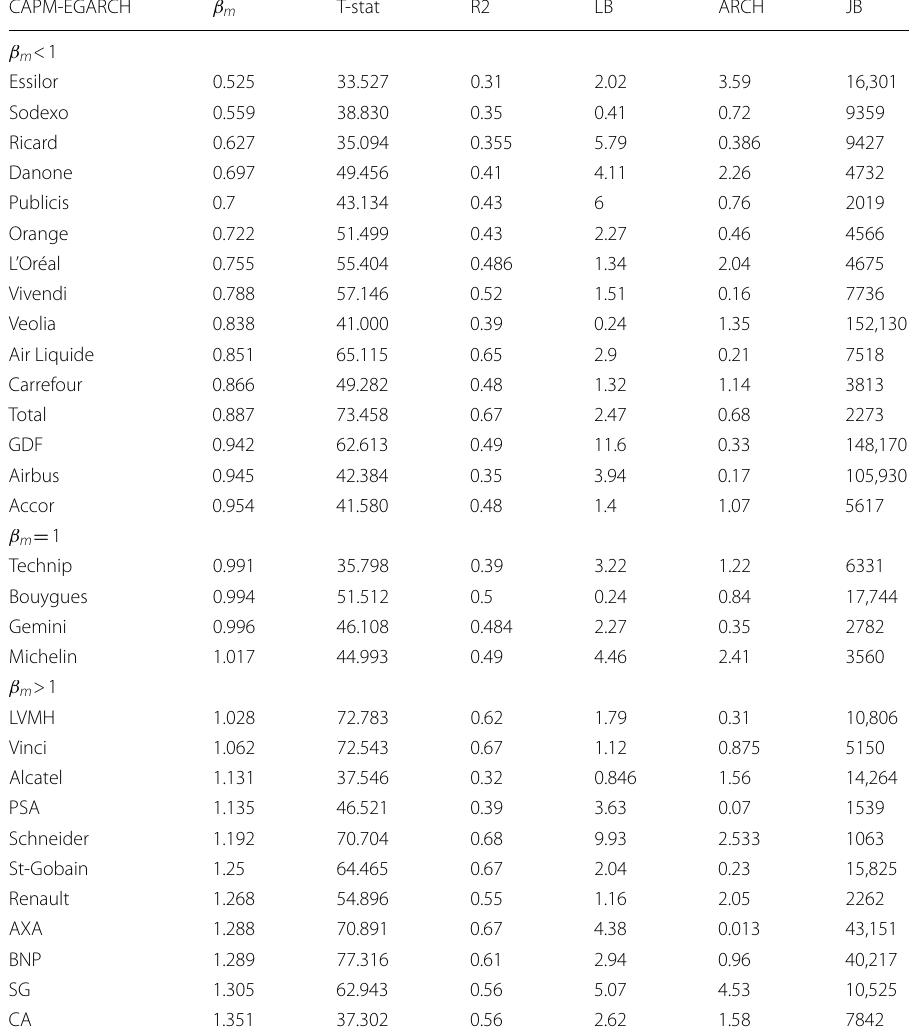
Table 9 CAPM-EGARCH